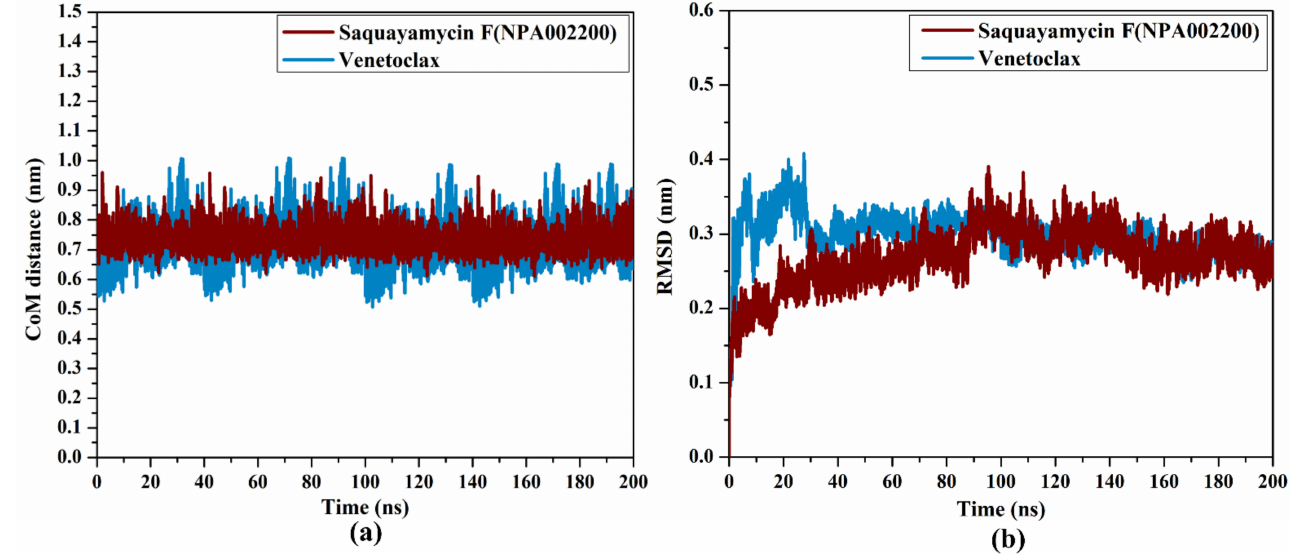
Figure 8. ( a ) CoM distance and ( b ) RMSD of the backbone atoms from the starting structure of saquayamycin F (in dark red) and venetoclax (light blue) in complex with the Bcl-2 protein during the 200 ns MD